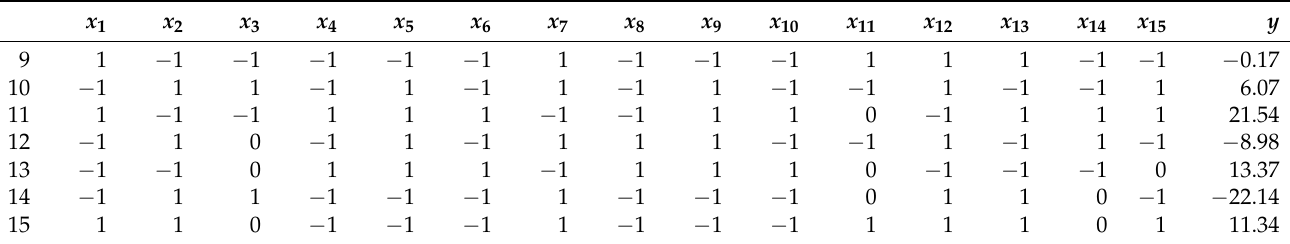
Table 3. Additional seven runs of the IBD-CAD for the SSD ( 8,13 ) .